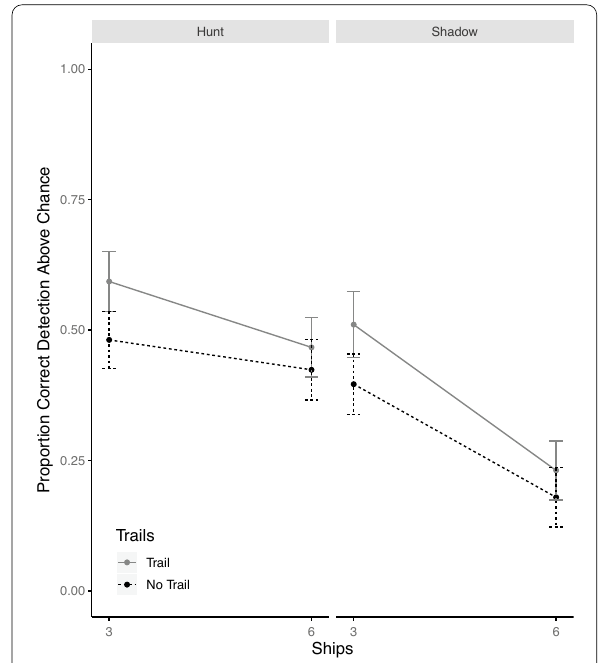
Fig. 4 Detection accuracy above chance as a function of set size, history trails and behavior. Error bars represent one standard error